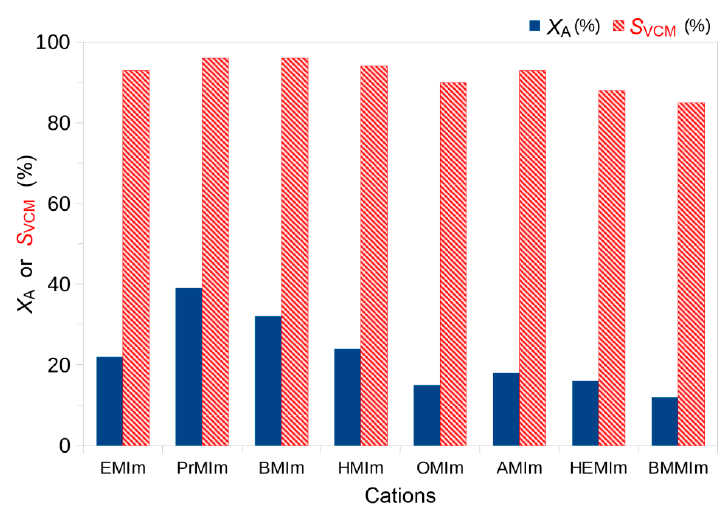
Figure 5. Acetylene conversion rate X A and VCM selectivity S VCM of the CuCl 2 catalyst, using IL [M]Cl with different cations [M] + as the reaction media. Reaction temperature 140 °C, C 2 H 2 GHSV = 370 h − 1 , V HCl :V C2H2 = 1.2, and [CuCl 2 ] = 0.065 mol L − 1 .